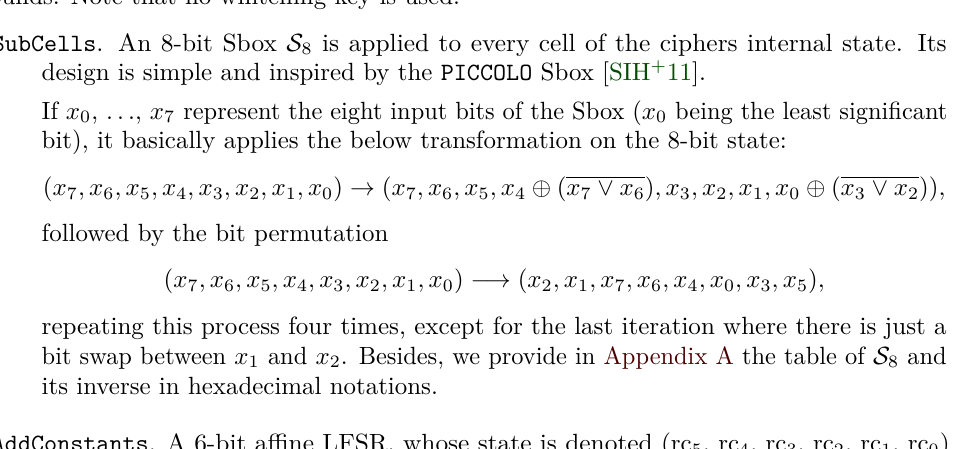
Figure 1: The SKINNY round function applies five different transformations: SubCells ( SC ), AddConstants ( AC ), AddRoundTweakey ( ART ), ShiftRows ( SR ) and MixColumns ( MC ). size. In particular, SKINNY-128-256 applies r = 48 and SKINNY-128-384 applies r = 56 rounds. Note that no whitening key is